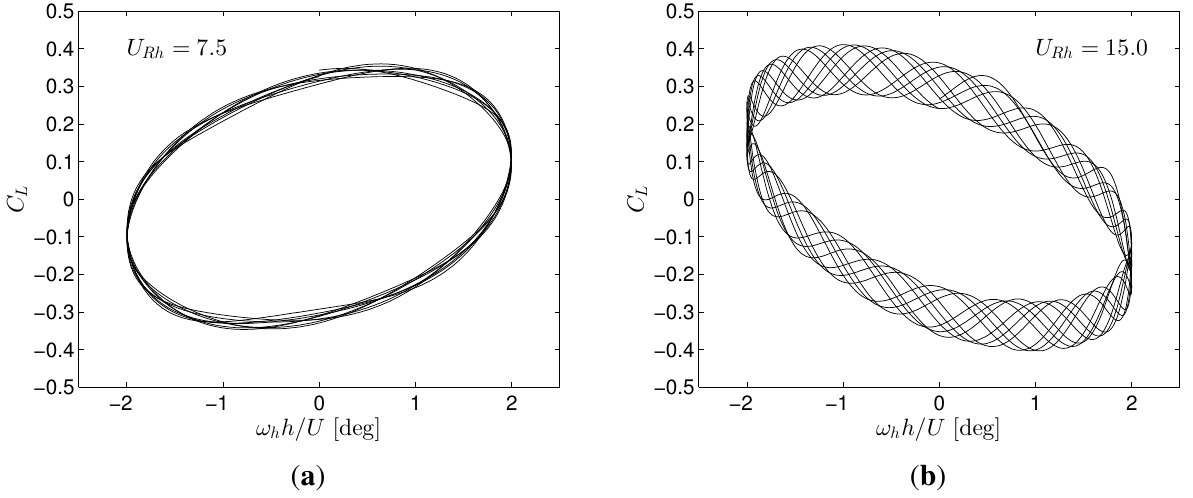
Figure 7. Numerically-simulated lift coefficient vs . apparent angle of attack in the case of heaving harmonic motion for a reduced flow speed equal to 7.5 ( a ) and 15.0 ( b